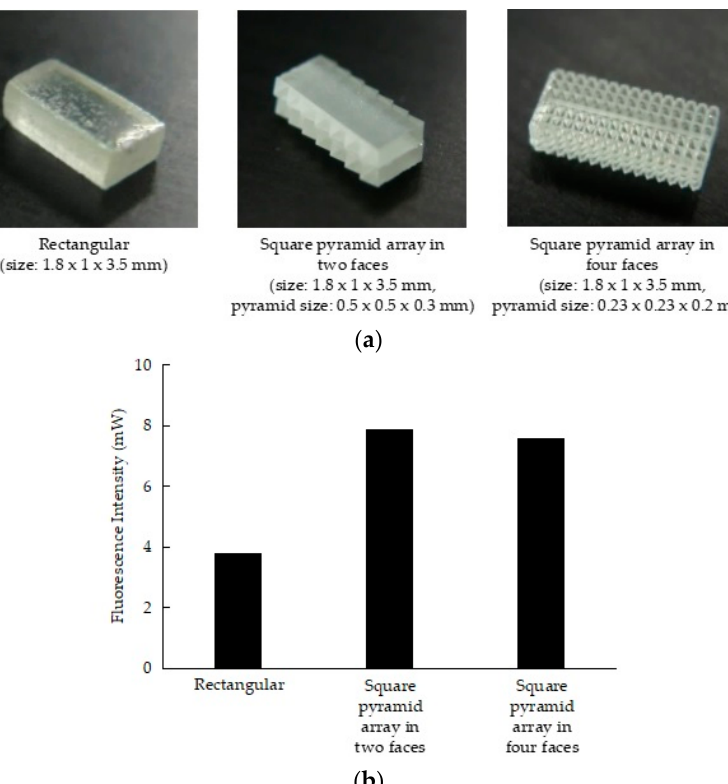
Figure 1. Photoluminescence spectrum of Yb 3+ and Nd 3+ co-doped Bi 2 O 3 -B 2 O 3 glass phosphor. Light with a wavelength of 808 nm is suitable for excitation.